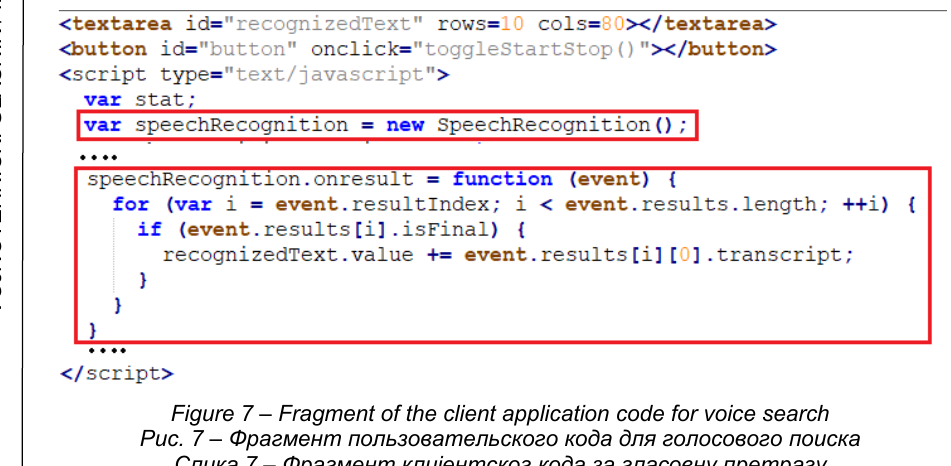
Figure 7 – Fragment of the client application code for voice search Рис . 7 – Фрагмент пользовательского кода для голосового